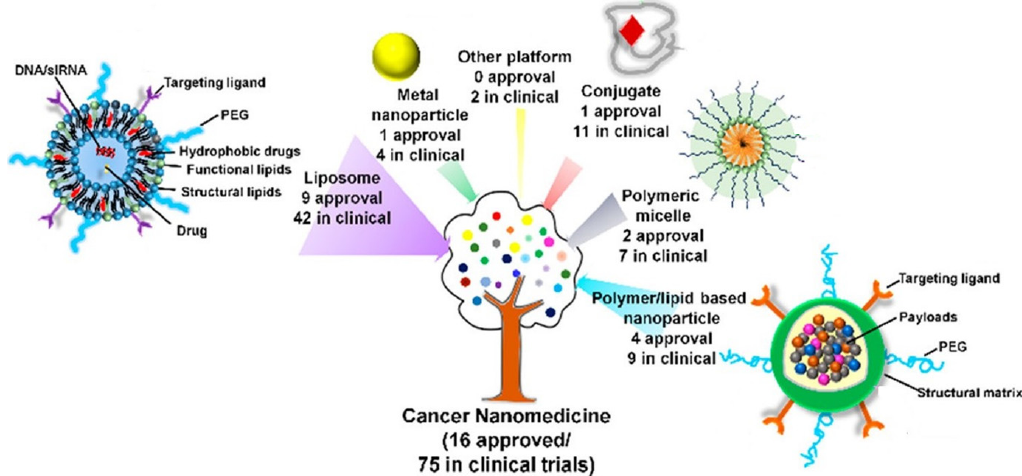
Figure 1. Schematic illustration of various types of cancer nanomedicine formulations—an outline of both approved and in clinical progress (adapted with permission from Reference [7], Accounts of Chemical Research, published by American Chemical Society, 2019).